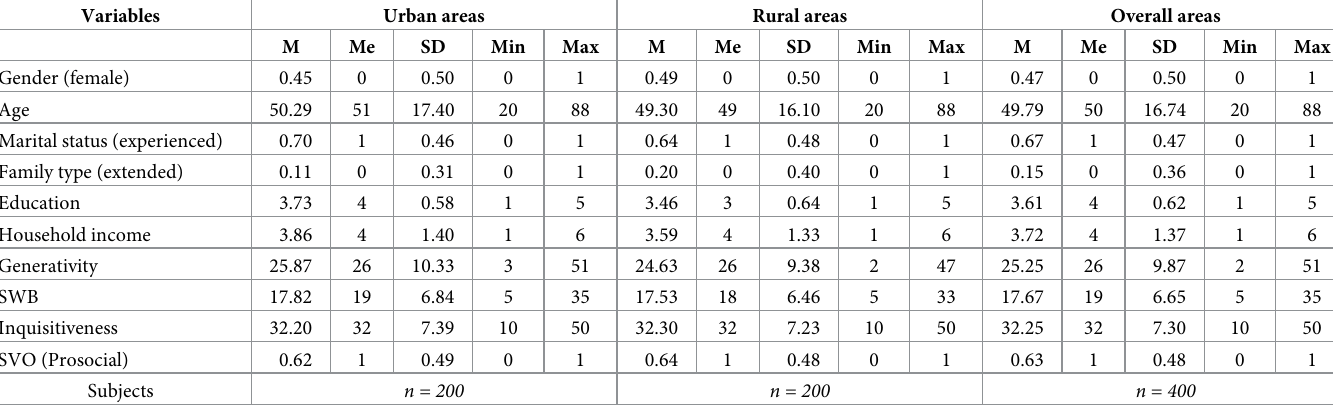
Table 2. Summary statistics of subject’s sociodemographic information and major variables.